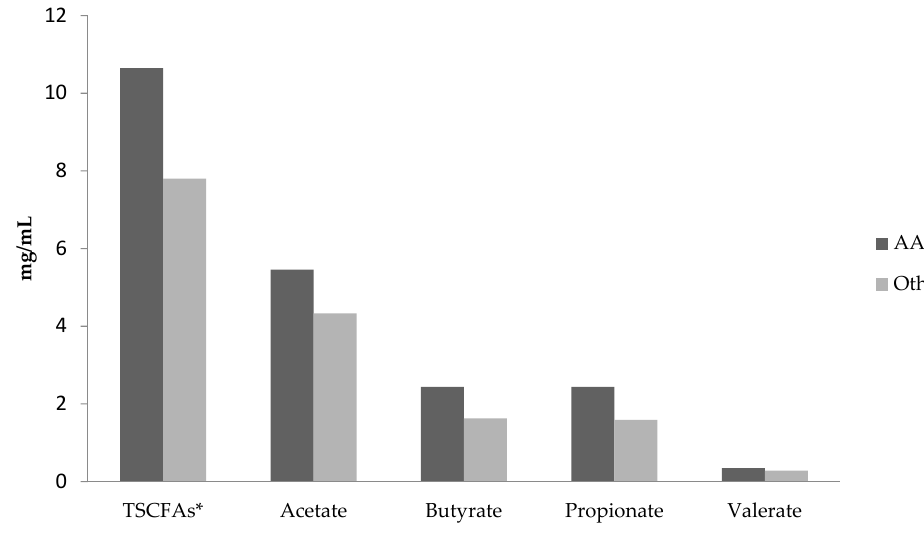
Figure 1. Levels of total short chain fatty acids (TSCFAs) and individual SCFAs for African Americans versus those of other race/ethnicities. All values in mg/mL of stool. * Statistically significant difference by linear regression, p = 0.029.